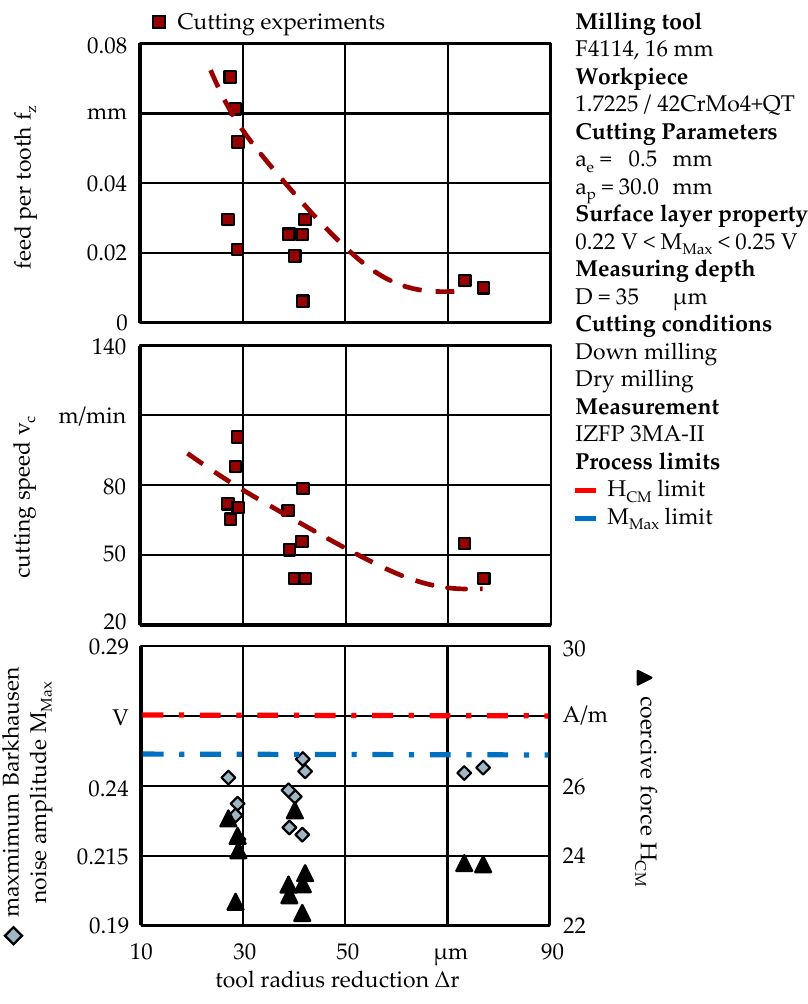
Figure 4. Cutting parameter adaption for compensation of the tool wear influence on MM.